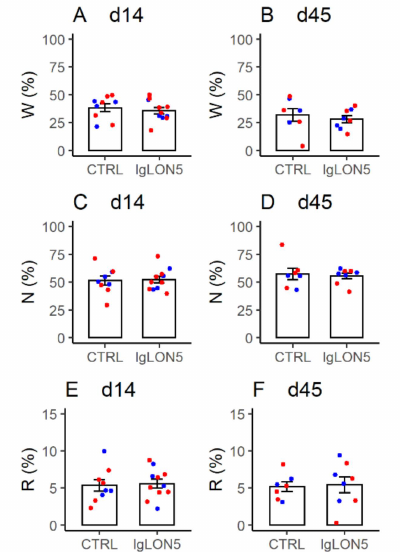
Figure 4. Percentage of the recording time spent in wakefulness (W), NREM sleep (N), and REM sleep (R) during the first 8 h of the light period by female wild-type (blue) and hTau (red) mice with intracerebroventricular infusion of antibodies from a patient with anti-IgLON5 disease (IgLON5) or from a control (CTRL) subject. ( A , C , E ): results obtained at the end of the 14-day infusion (d14). ( B , D , F ): results obtained ≥ 1 month afterward (d45). Bars show means ± SEM. Dots show values in individual mice. Detailed statistical results are reported in Tables